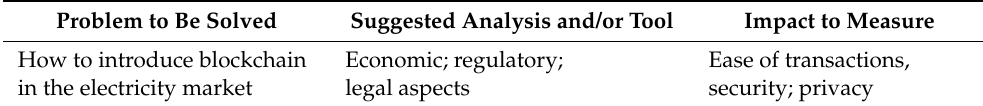
Table 10. Problems, suggestions, and impacts of blockchain. Source: own study.